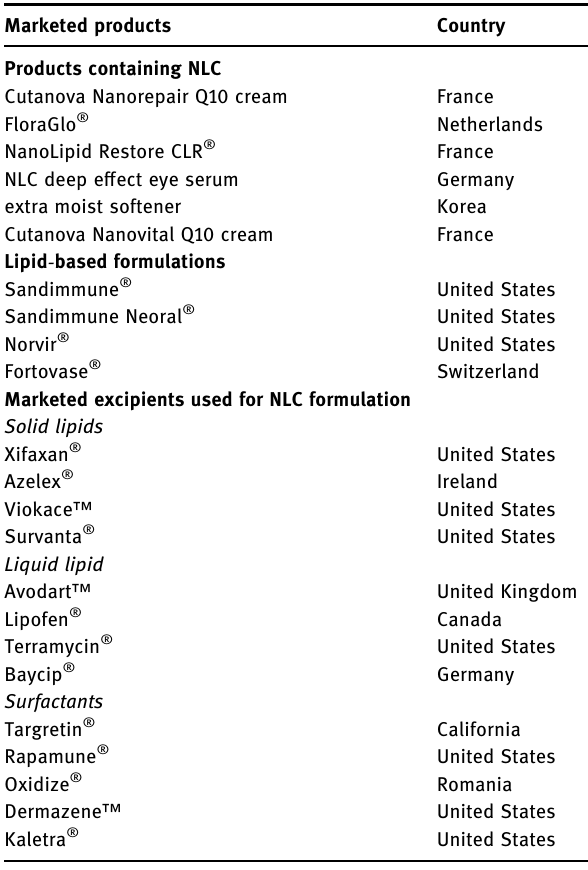
Table 7: Marketed NLCs containing formulations, excipients, and